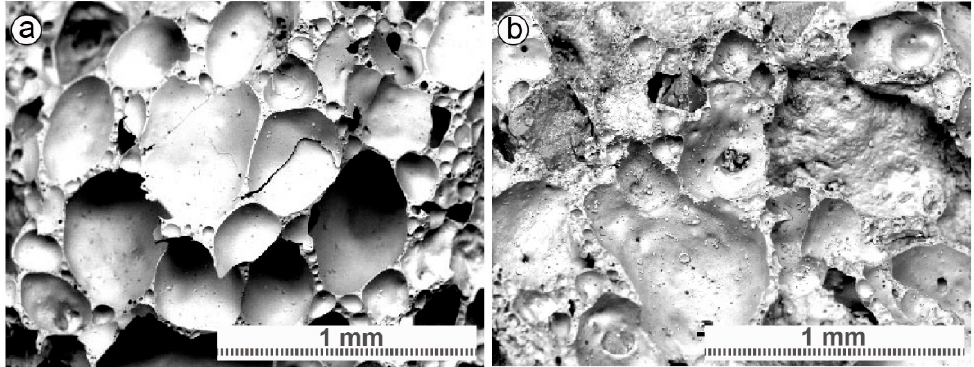
Figure 1. Morphological features of the particle surface for Arlita ( a ) and Filtralite ( b ).